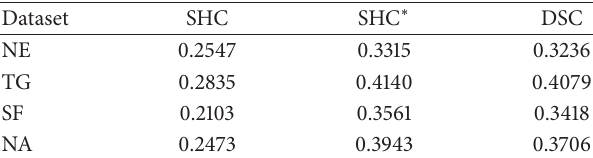
Table 1: Index generation time (ms).